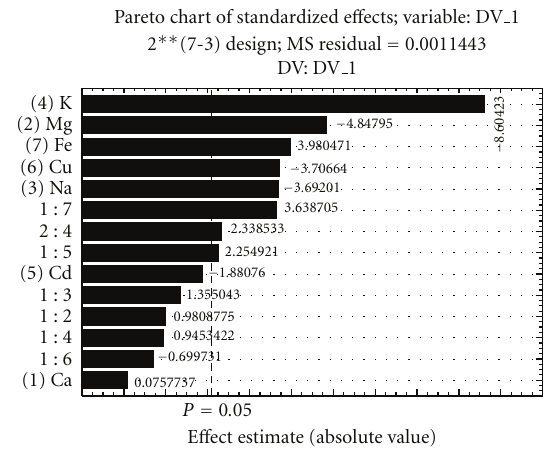
Figure 5: Pareto chart of e ff ects of interfering ions on zinc adsorption in the proposed preconcentration